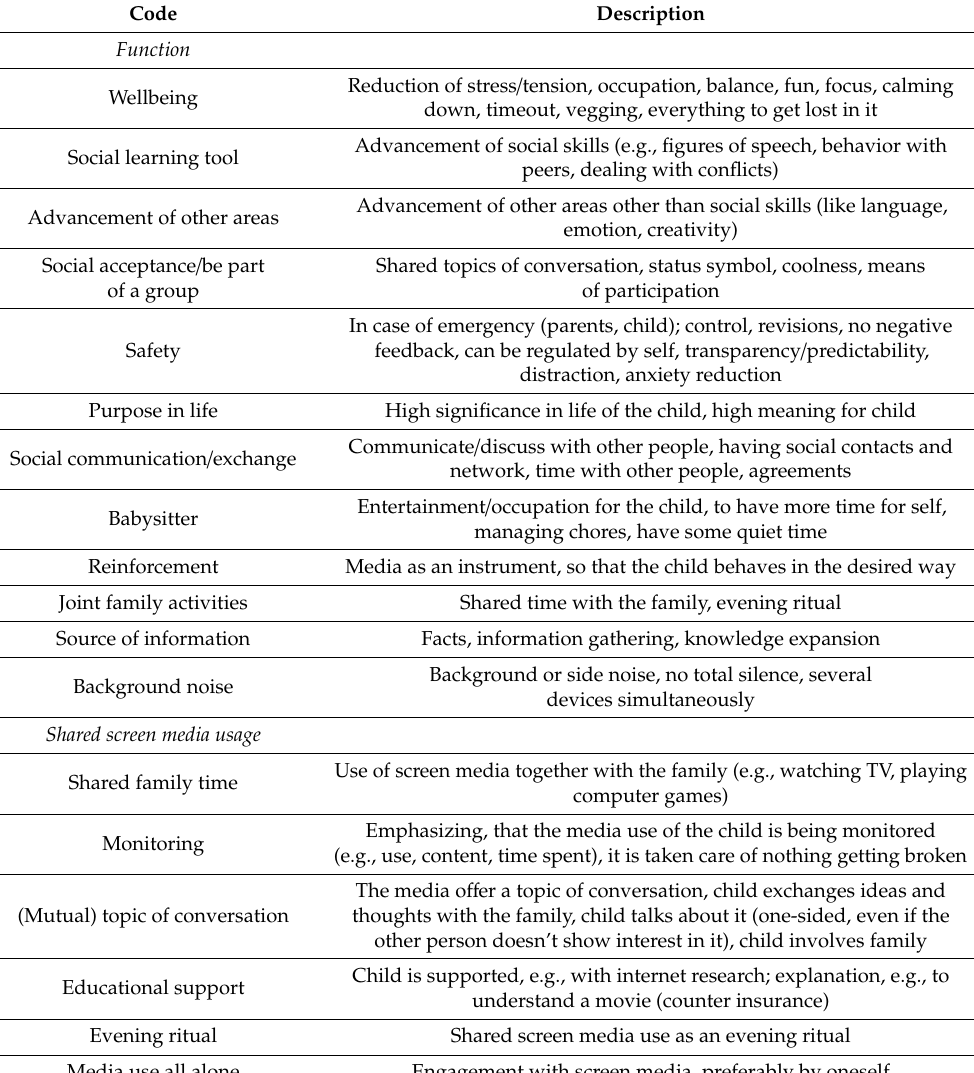
Table 1. Coding guidelines